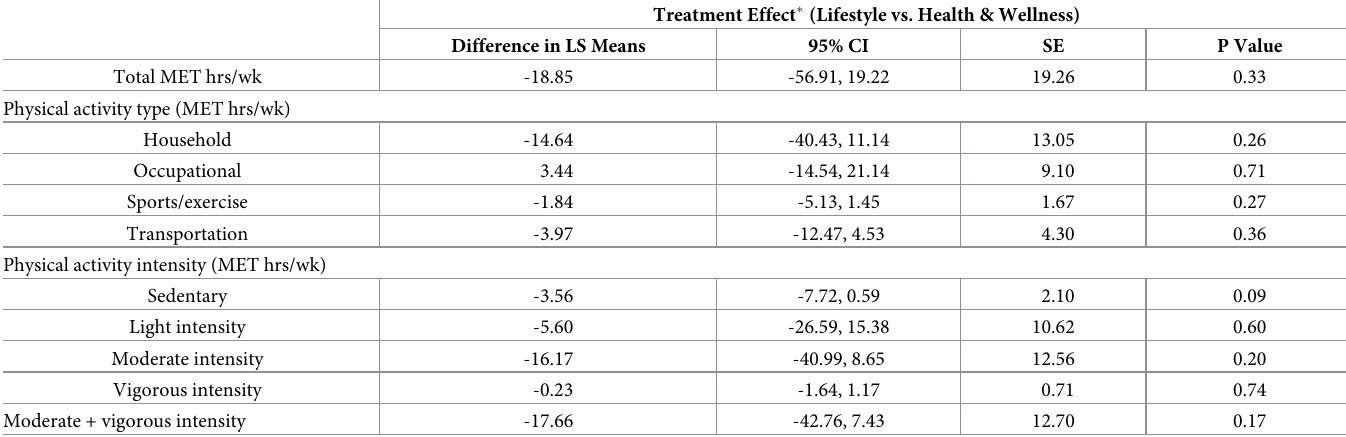
Table 4. Main effects model: Differences in change in physical activity from baseline over follow-up between intervention groups; Estudio PARTO